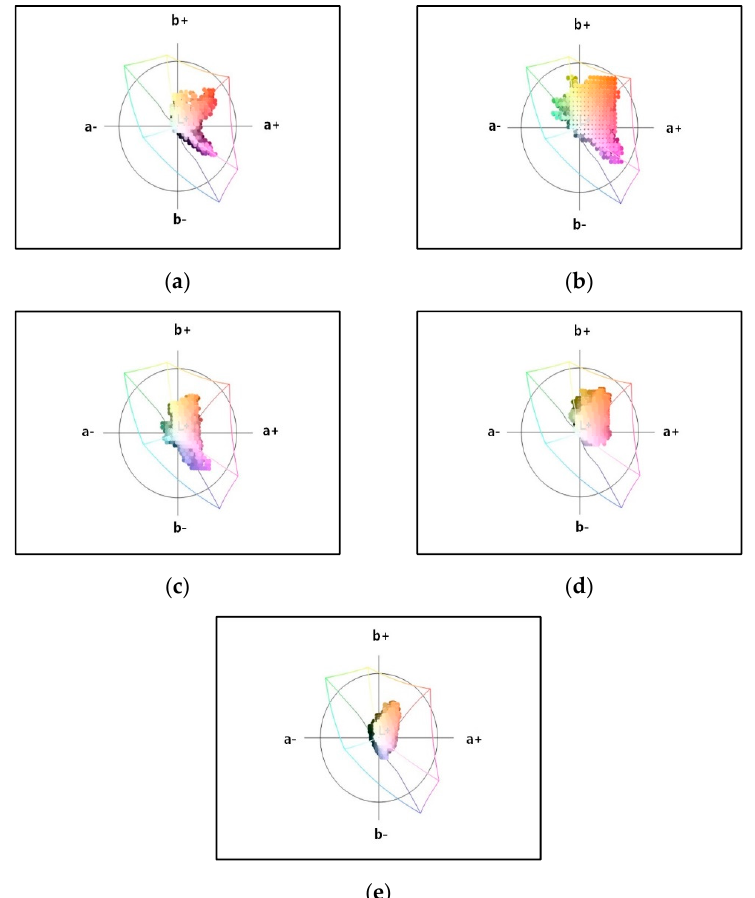
Figure 8. Gamut areas of Figure 4 images: ( a ) an original HDRI and resulting images of ( b ) iCAM06, ( c ) Reinhard’s method, ( d ) Choi’s method, and ( e ) the proposed